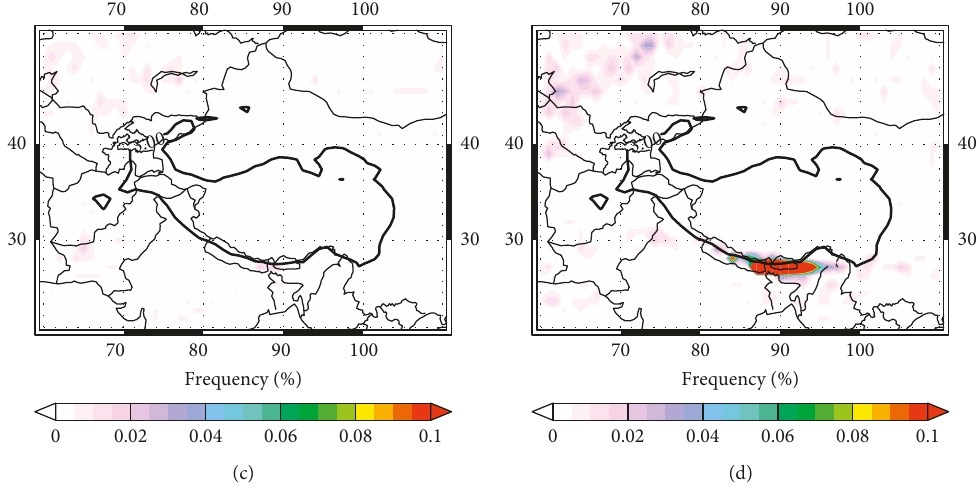
Figure 5: The same as Figure 3, but for deep tropopause fold